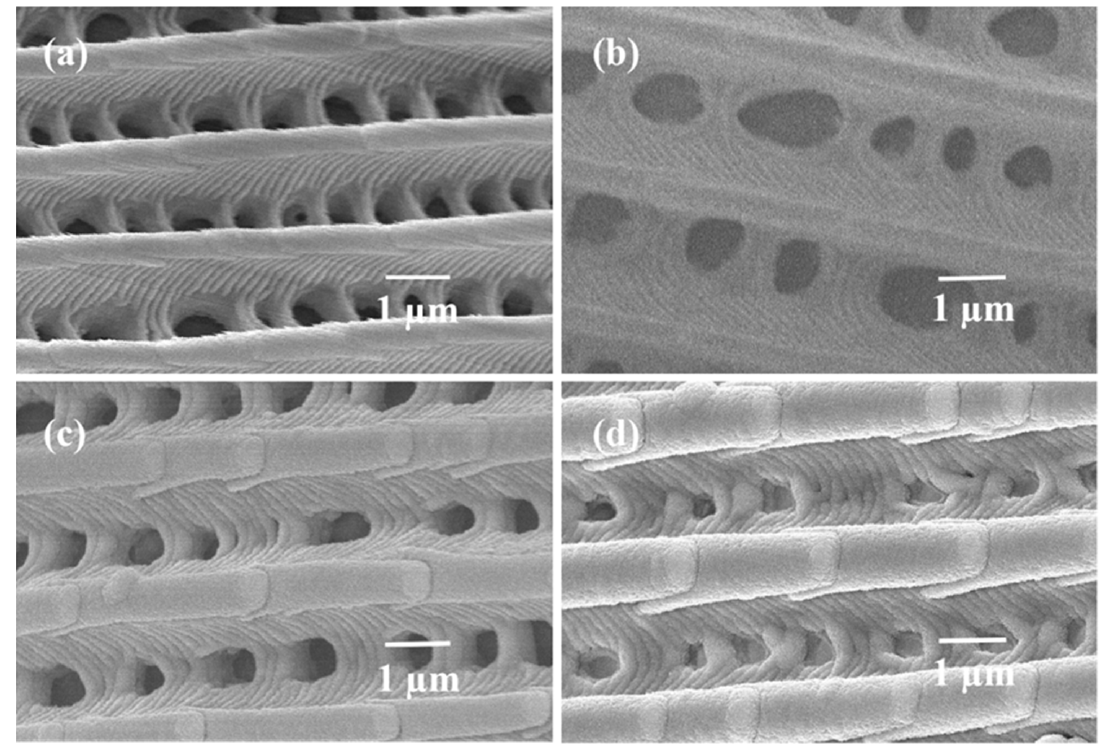
Figure 3. Top view FE ‐ SEM images of the AgCu@MW substrates with different co ‐ sputtering times: ( a ) AgCu@MW ‐ 10, ( b ) AgCu@MW ‐ 15, ( c ) AgCu@MW ‐ 20 and ( d ) AgCu@MW ‐ 25.